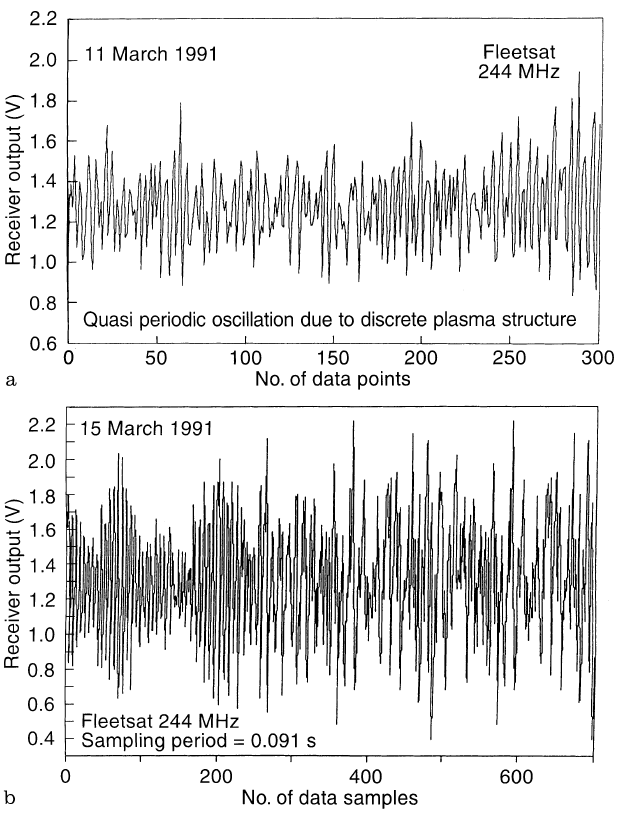
Fig. 4. The typical power spectrum obtained for stage 2 quasiperiodic scintillation. A dominant spectral peak is seen at (cid:25) 3 Hz corresponding to a spatial conversion of (cid:25) 33 m due to the drift velocity of 112